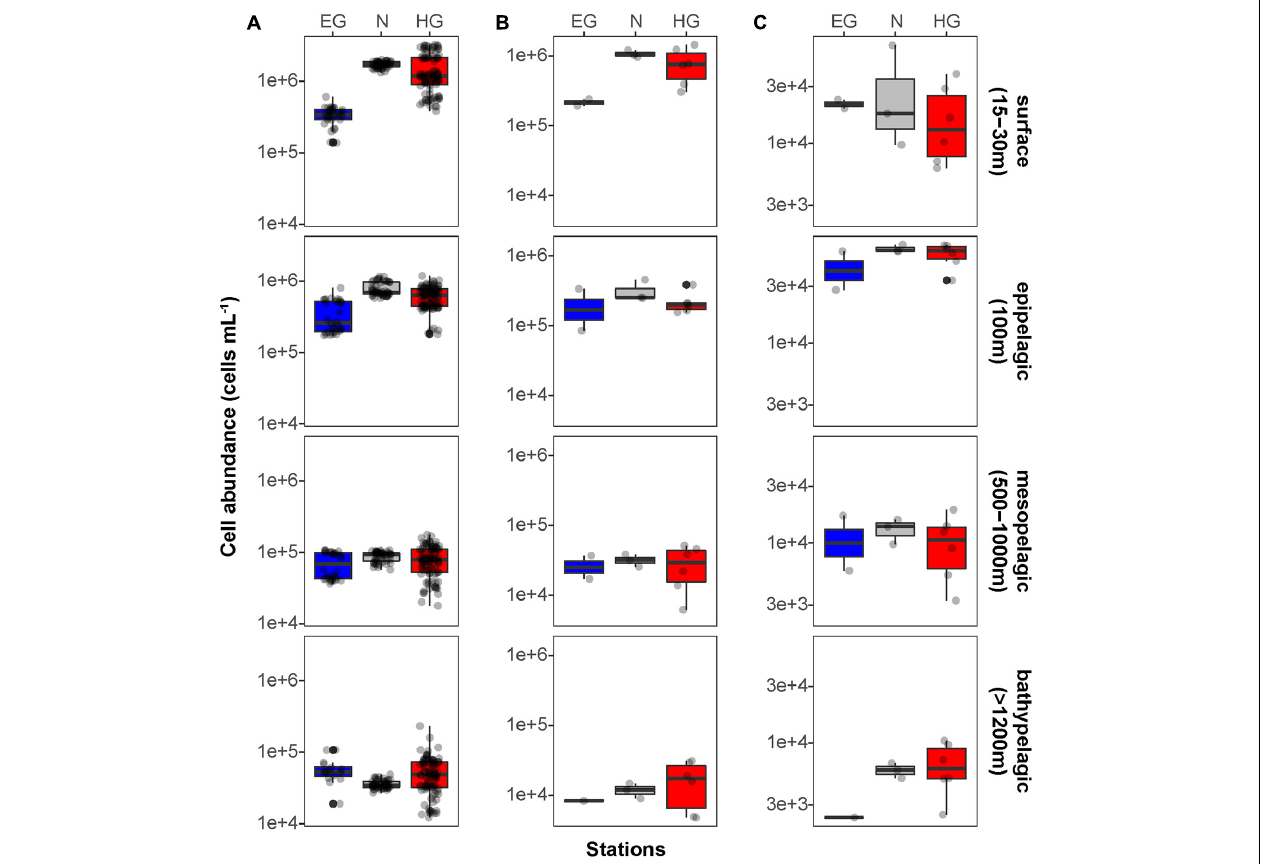
FIGURE 2 | Mean bacterioplankton cell abundances calculated in the different regions of the Fram Strait: Total bacterioplankton in panel (A) ; Bacteria in panel (B) ; and Archaea in panel (C) . Box plots were calculated based on cell abundance. Note the different scale of the cell abundances for Archaea . The different regions are indicated by color: ice-covered EGC–blue (EG stations), ice-margin N–gray (N stations), ice-free WSC–red (HG